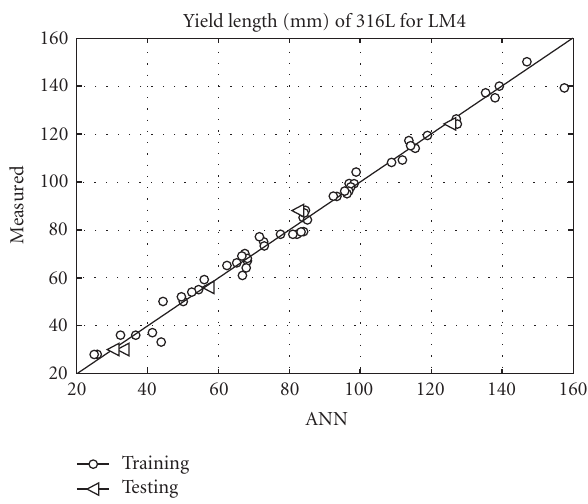
Figure 22: Comparison of the measured and predicted yield length for